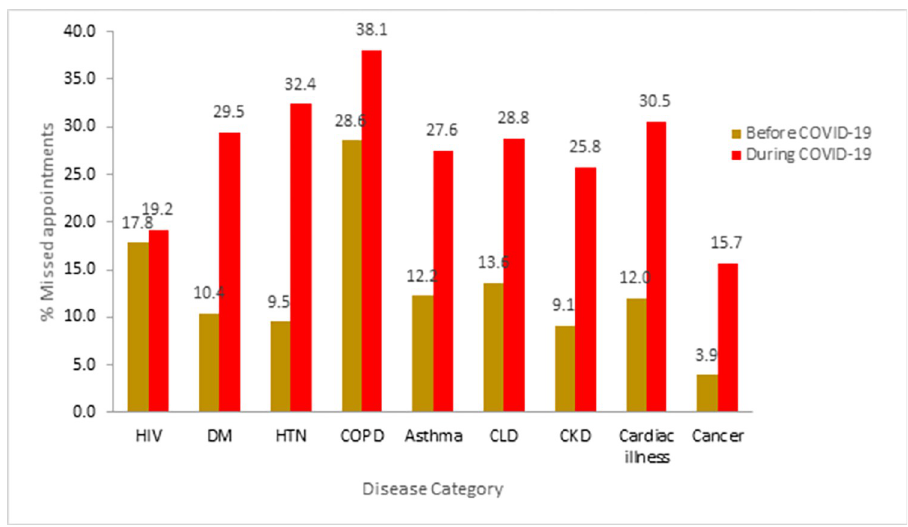
Fig 2. Missed appointment before COVID 19 pandemic and during the pandemic among common chronic disease patients in Amhara Region.